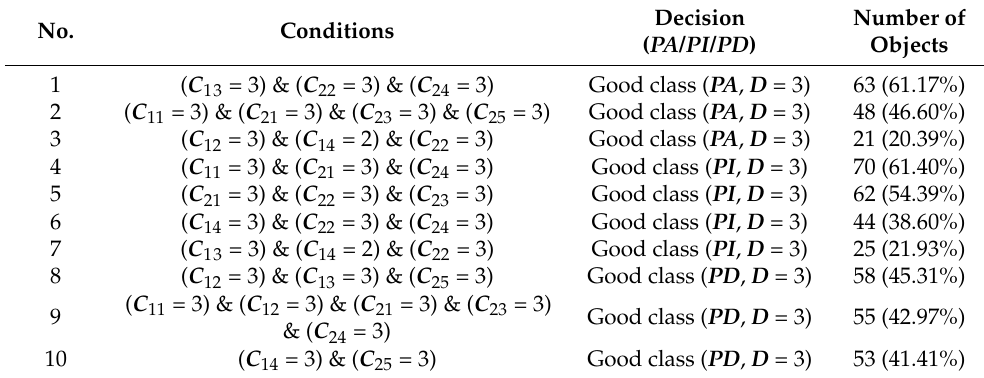
Table 5. Minimal covering rules with strength exceeding 10% in Decision =